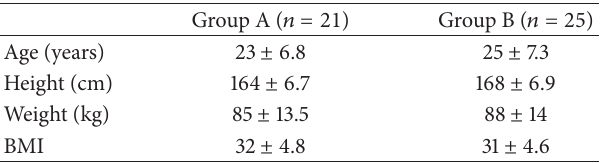
Table 1: Characteristics of patients who received MI plus DCI (group A) or placebo treatment (group